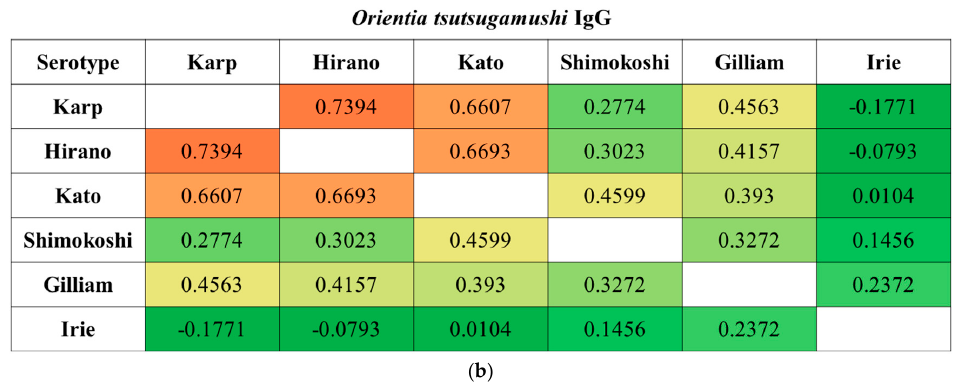
Figure 2. Spearman’s rank correlation coefficients between each O. tsutsugamushi serotype. The correlation coefficients in IgM(a) and IgG(b) samples were calculated using titers when a diagnosis of scrub typhus was made ( n = 190): paired samples, n = 138; single sample, n = 52. Abbreviations: Irie, Irie/Kawasaki; Hirano, Hirano/Kuroki.